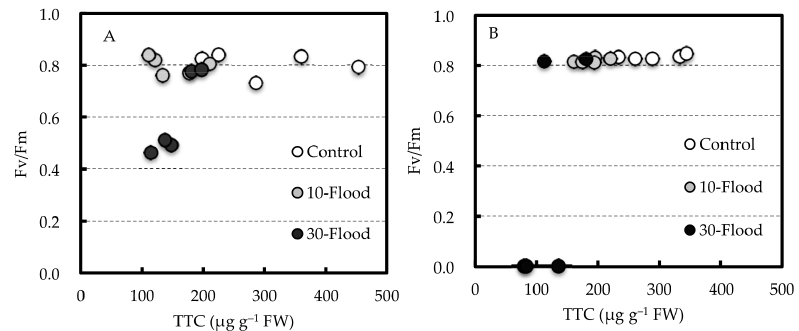
Figure 6. Relationship between TTC reduction of roots and Fv/Fm of leaves in grafted mango trees during or after treatments. Fv/Fm and TTC in ( A ) were measured on 28 July and 31 July, respectively, and those in ( B ) were undertaken on 25 August and 28